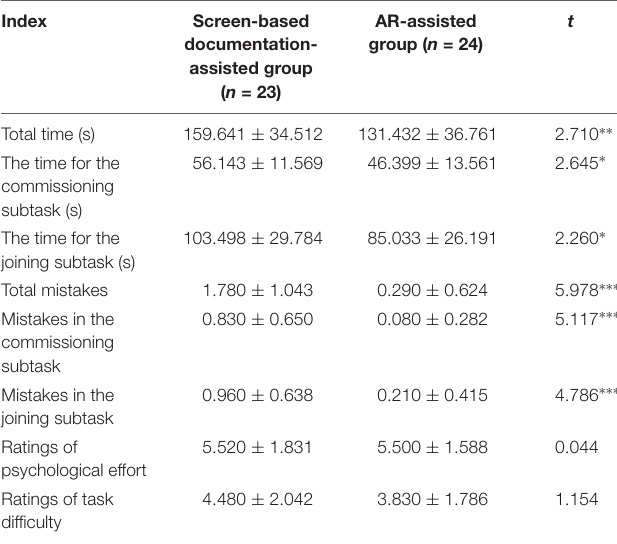
TABLE 1 | Differences of the two assistance modes in terms of the performance and cognitive load of the assembly task.